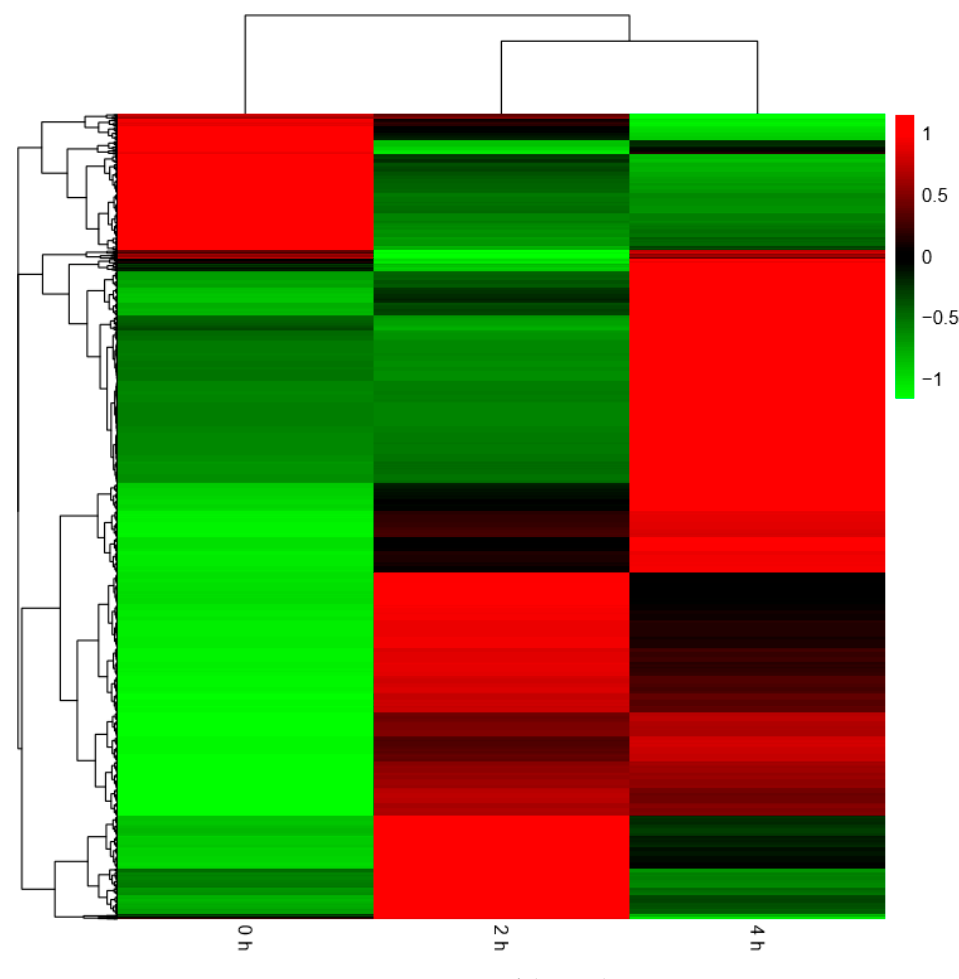
Figure 9. Heat-map of the total DEGs.